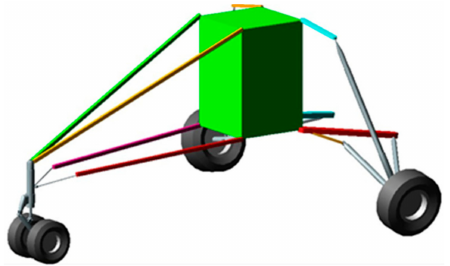
Figure 4. Mil Mi-8 helicopter multibody